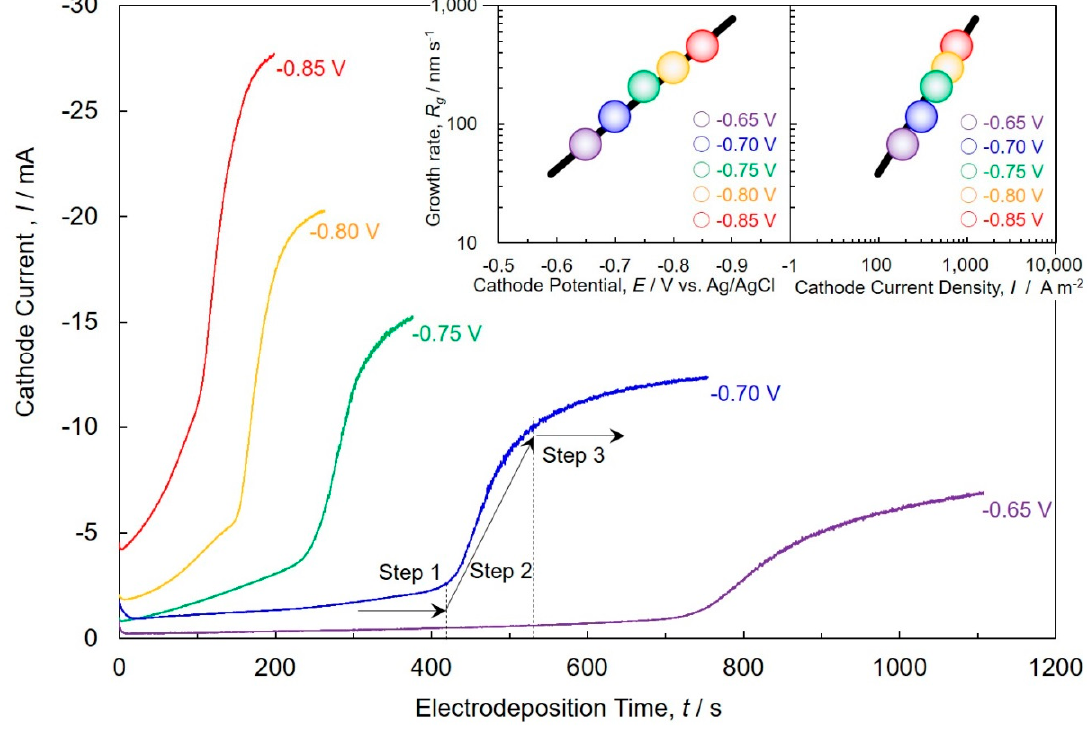
Figure 5. Time-dependence of cathode current during the electrodeposition of Co nanowires in the nanochannels of anodized aluminum oxide templates. Insets: Effect of the cathode potential and the cathode current density on the growth rate of electrodeposited Co nanowire arrays.